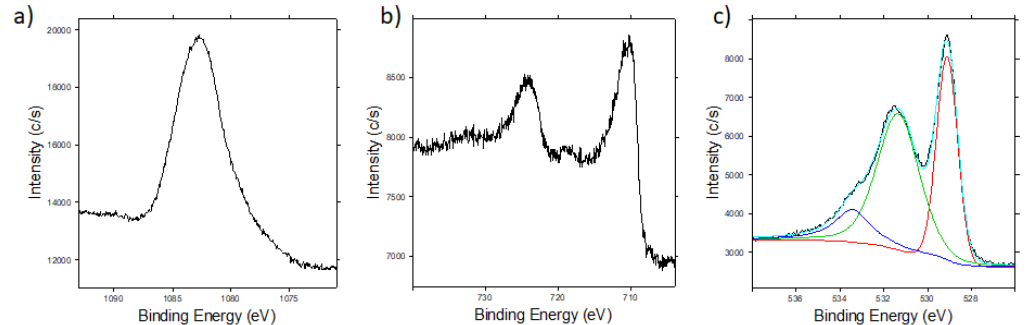
Figure 5. ( a ) Samarium Sm 3d 5 / 2 , ( b ) iron Fe 2p and ( c ) oxygen O 1s core levels of the SmFeO 3 powder deposited on the carbon tape.